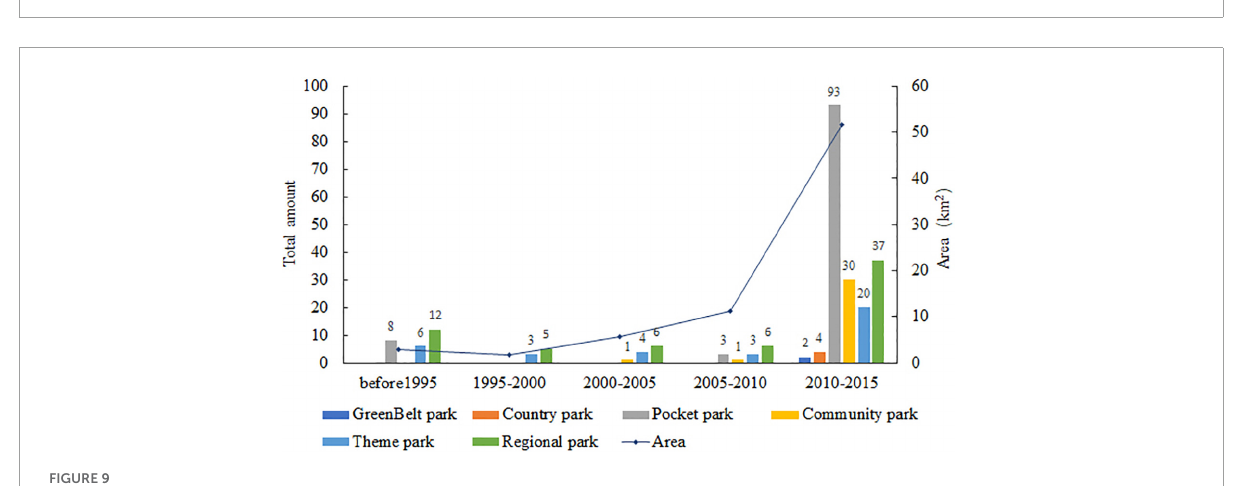
during different periods of urbanization is shown in Figure 9